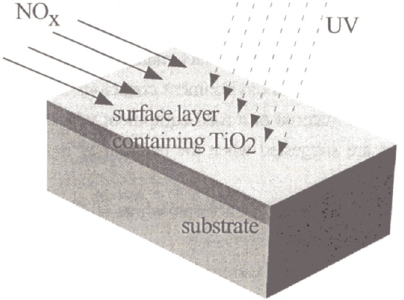
Figure 30. Paving brick for NO x removal; dimensions of brick: 10 cm × 20 cm; thickness of the surface layer containing TiO 2 : 5–7 mm. Reproduced from Murata et al. [122].